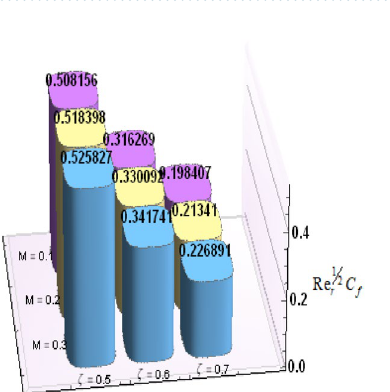
Figure 12. Bar chart representation of Skin friction coefficient and Nusselt number for different parameters using Mathematica 10 software available at (https:// softa sm. com/ wolfr am- mathe matica- 10-4- full- crack/). Re1 /2 r C f versus θ e .